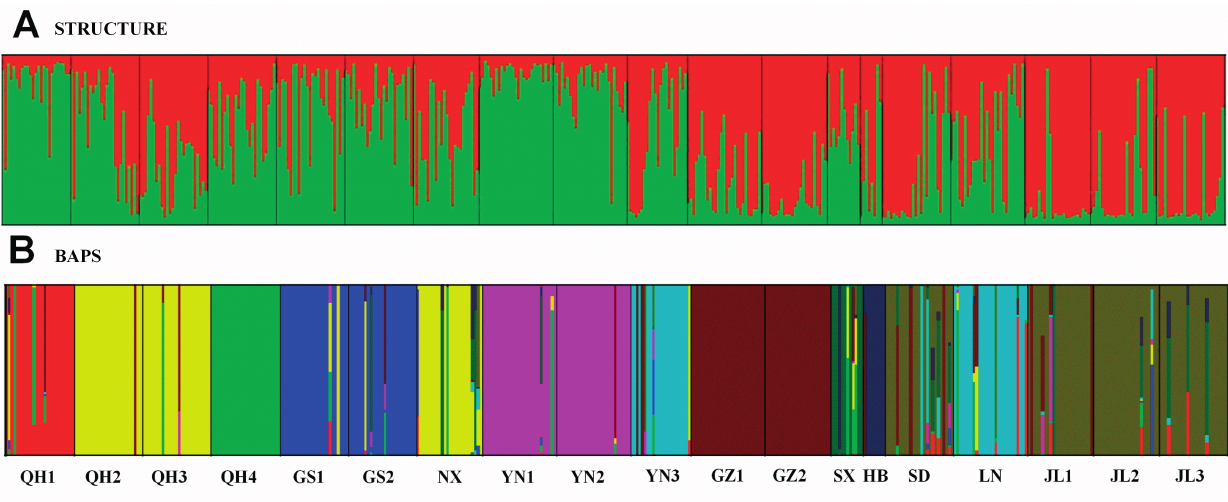
Figure 3. Results of genetic clustering using STRUCTURE ( a ) and BAPS ( b ) analysis, based on the 7 microsatellite loci used in the